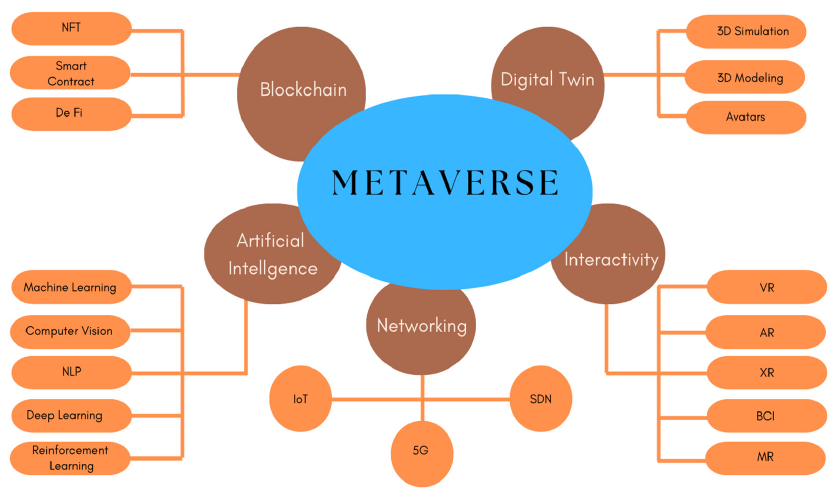
Figure 1. Building block technologies of the metaverse.